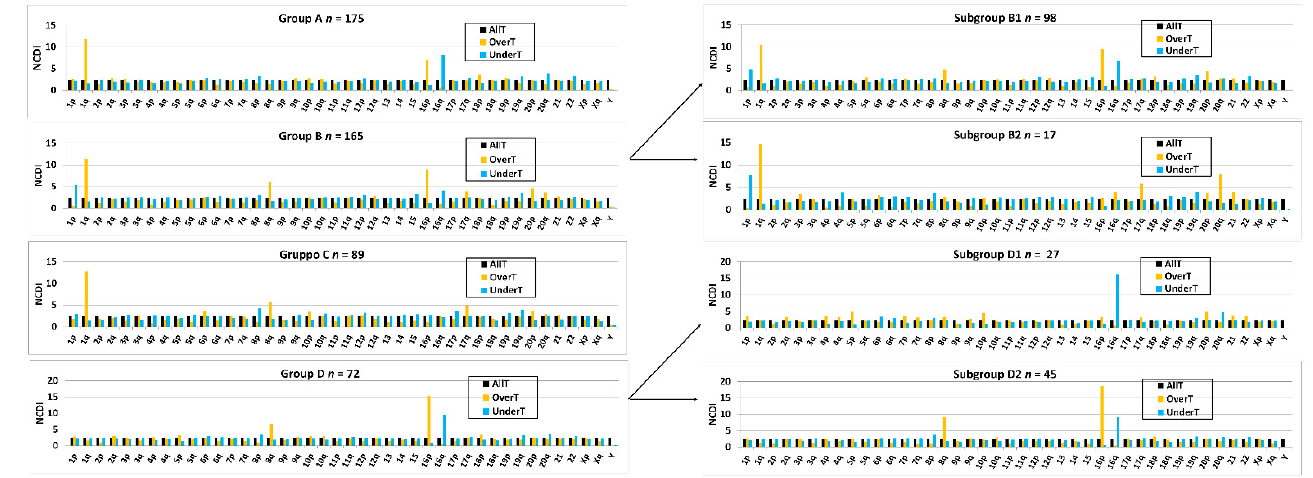
Figure 5. The normalized chromosomal distribution index (NCDI) of OverT (Overexpressed Transcript in comparison to CTRL) and UnderT (Underexpressed Transcript in comparison to CTRL of each 1,16-chromogroup. NCDI values of all transcripts (AllT) analyzed by RNA-seq in each chromosomal arm are also reported for comparison.